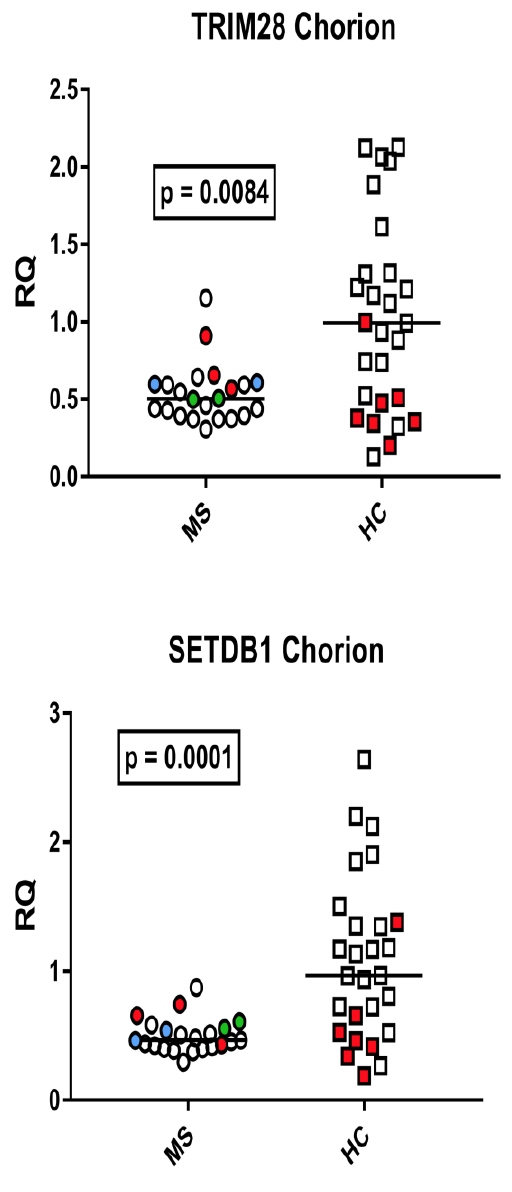
Figure 7. Expression of TRIM28 and SETDB1 in the chorion of 22 placentas from 20 mothers with multiple sclerosis (MS) and in 27 healthy control (HC) mothers. RQ: relative quantification. Circles and squares show the mean of three individual measurements; horizontal lines show the median values. Premature deliveries are shown in red; these include two pairs of twins in blue and green. Medians and IQR 25 – 75%: HERV-H- pol : Group A (mothers with MS) 0.95, 0.76 – 1.09; Group B (un-affected mothers) 1.07, 0.82 – 1.23; HERV-K- pol : Group A 0.97, 0.72 – 1.15; Group B 1.11, IQR 0.81 – 1.24; HERV-W- pol : Group A median 1.67, IQR 1.34 – 1.92; Group B 1.04, 0.87 – 1.40; SYN1- env : Group